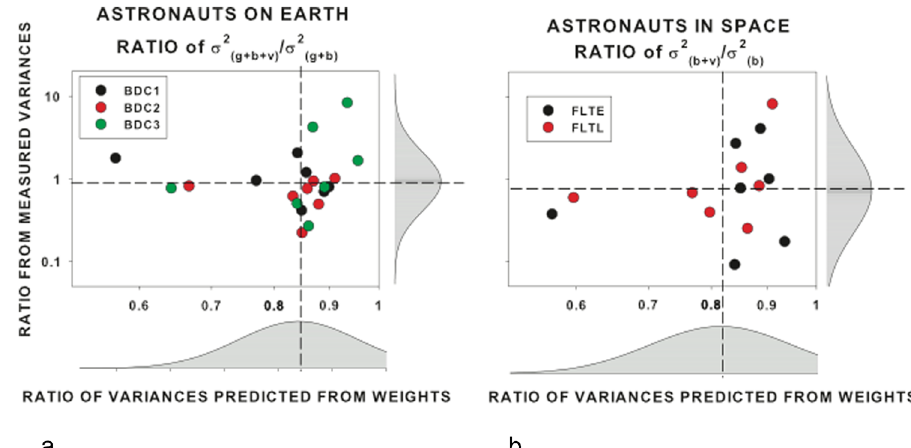
Fig. 6 Comparison of variances calculated from the weightings using the vector sum model (see text, horizontal axis ) with the measured variances ( vertical axis ). Each axis plots the ratio of variance with all cues present to the variance without the visual cue on log – log scales. a On earth, gravity, body and vision cues contribute to the all-cues-present condition. b In space, only body and vision cues are present. Distributions of the data are given on each axis